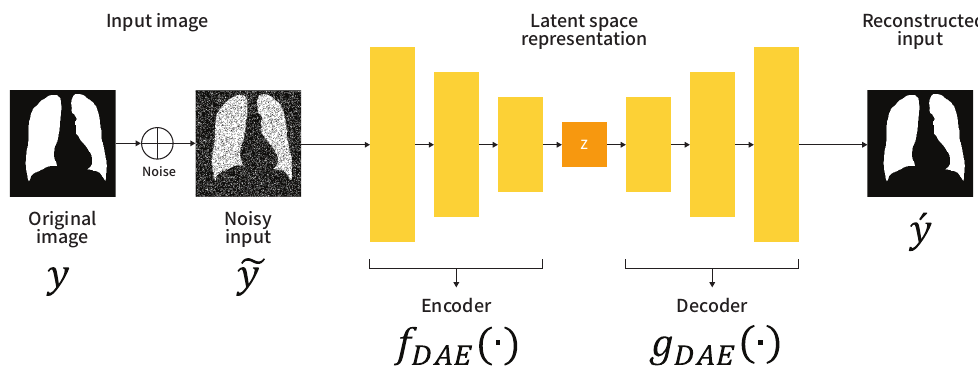
Figure 1. Architecture of the denoising convolutional autoencoder